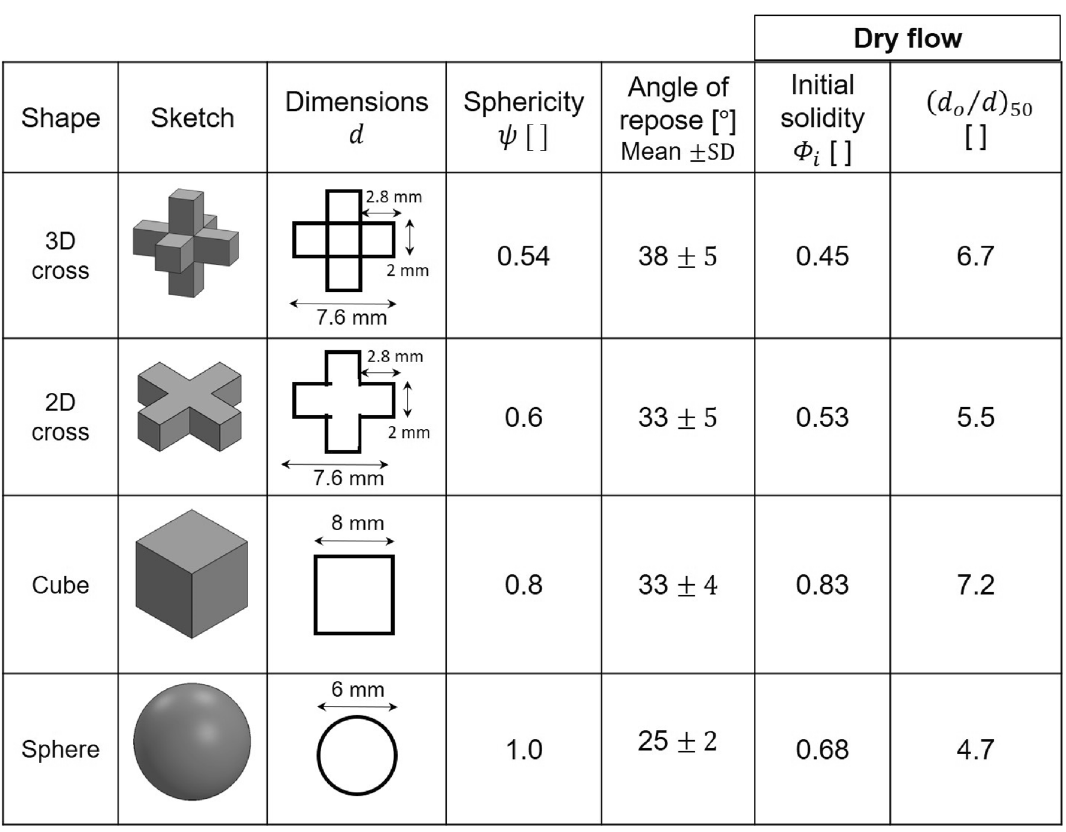
Figure 1. Particle shapes tested in this study. The angle of repose expressed as the mean ± the standard deviation SD. The initial packing density or solidity inside the hopper before discharge Φ i . The characteristic size ratio ( d o / d ) 50 obtained by fitting Eq. (2) to data in Fig.